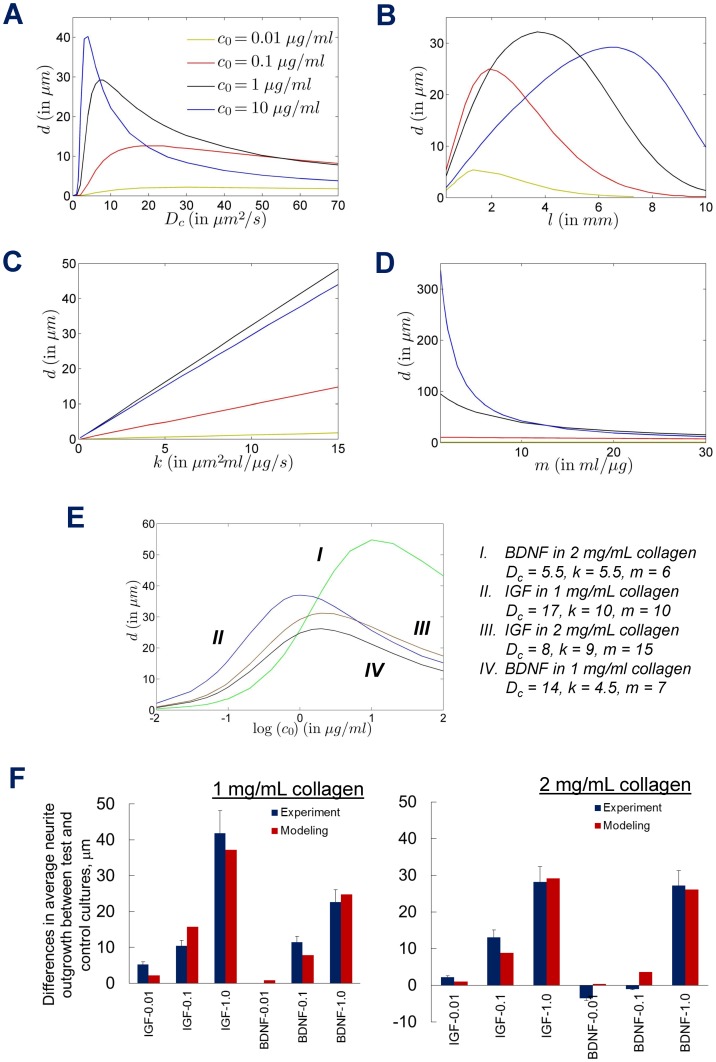
Mathematical modeling of neurite outgrowth.The effect of various parameters of the model on the distance traveled by growth cones (neurite outgrowth), when the boundary concentration c0 is set at 0.01, 0.1, 1 and 10 µg/mL. The curves at c0 = 10 µg/mL demonstrate the predictability power of this model. (A–D) Effects of the diffusion coefficient (Dc), length (l) of the domain, and the chemotaxis parameters k and m, on growth cone movement. Unless otherwise mentioned, the parameter values are Dc = 8 µm2/s, l = 5 mm, k = 9 µm2mL/µg/s, and m = 15 mL/µg. (E) Effect of the boundary concentration c0 on the distance moved by the growth cone for different sets of culture conditions (BDNF or IGF, 1 mg/mL or 2 mg/mL collagen) investigated in this study. The respective parameter values of Dc, k and m are provided for each curve. (F) Strong correlation between simulation results and experimentally-observed data was noted for the average neurite outgrowth under respective culture conditions.